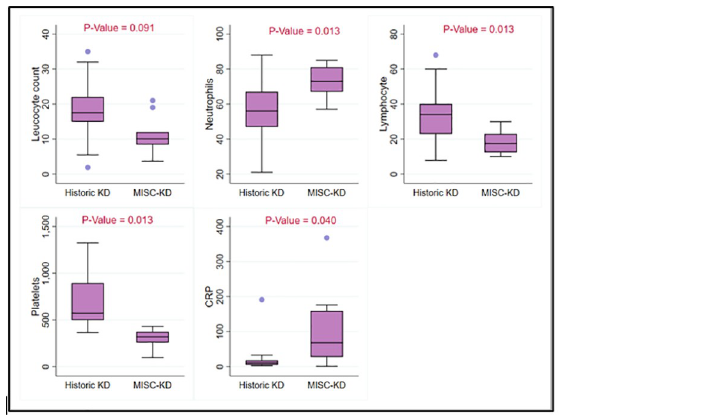
Fig 3. Laboratory features comparison in MISC and historic KD.